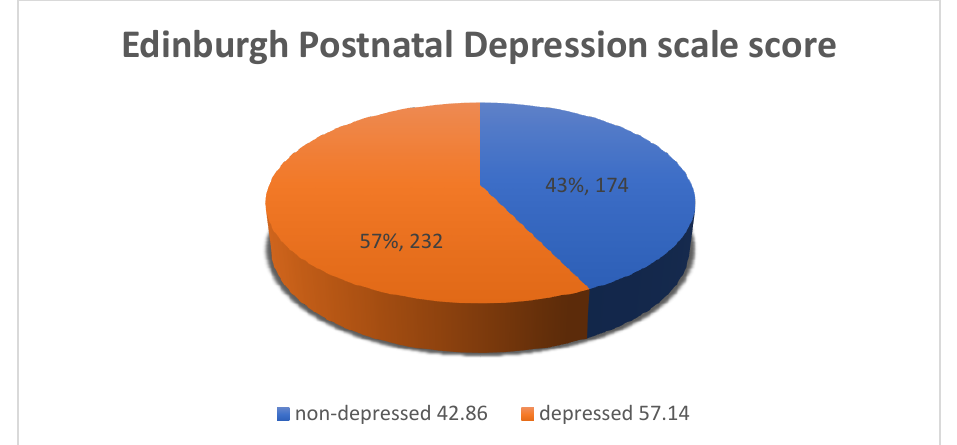
Figure 1. Proportion of PND (postnatal depression).